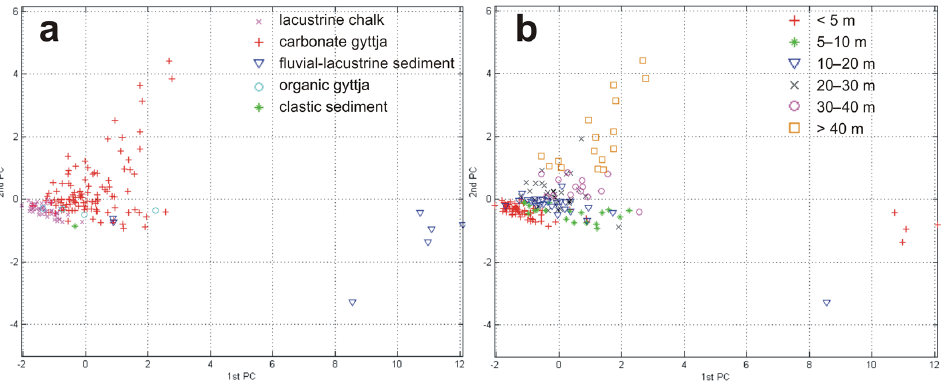
Figure 2. Principal component analysis (PCA) carried out for 177 Wigry Lake sediment samples, visualized according to sediment type ( a ) and depth ( b ).